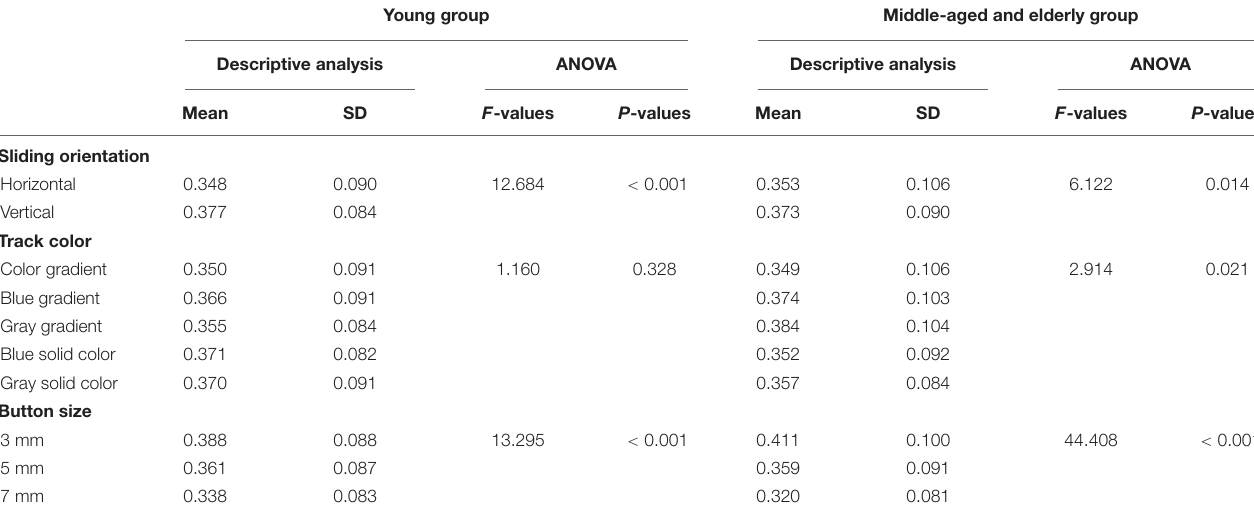
TABLE 5 | Main effects of sliding orientation, track color, and button size on mean fixation time (s).